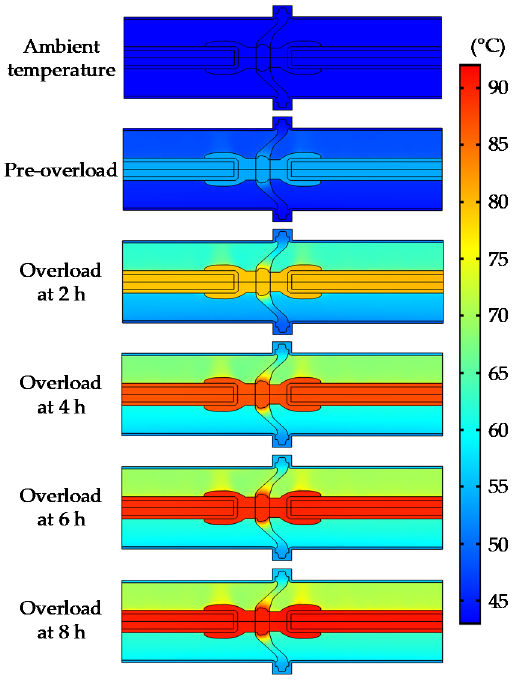
Figure 15. Temperature distribution of the spacer and GIL at different overload stages.